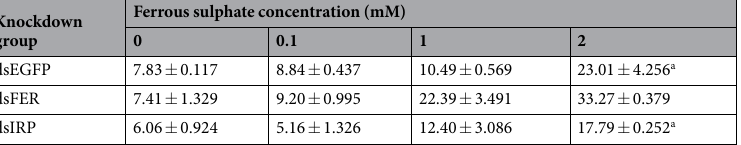
Table 5. Mortality (%) of knockdown cells exposed to different concentrations of ferrous sulphate at 48 h Data are presented as mean ± S.D. The results for the normality and homogeneity are presented in Table S13. A Kruskall-Wallis test with Bonferonni multiple comparison test was performed (Tables S14 and S15). Statistical significance was set as * P < 0.05. Columns with the same superscript are not significantly different at P < 0.05. The data presented are results of three separate experiments with two technical replicates for each experiment.